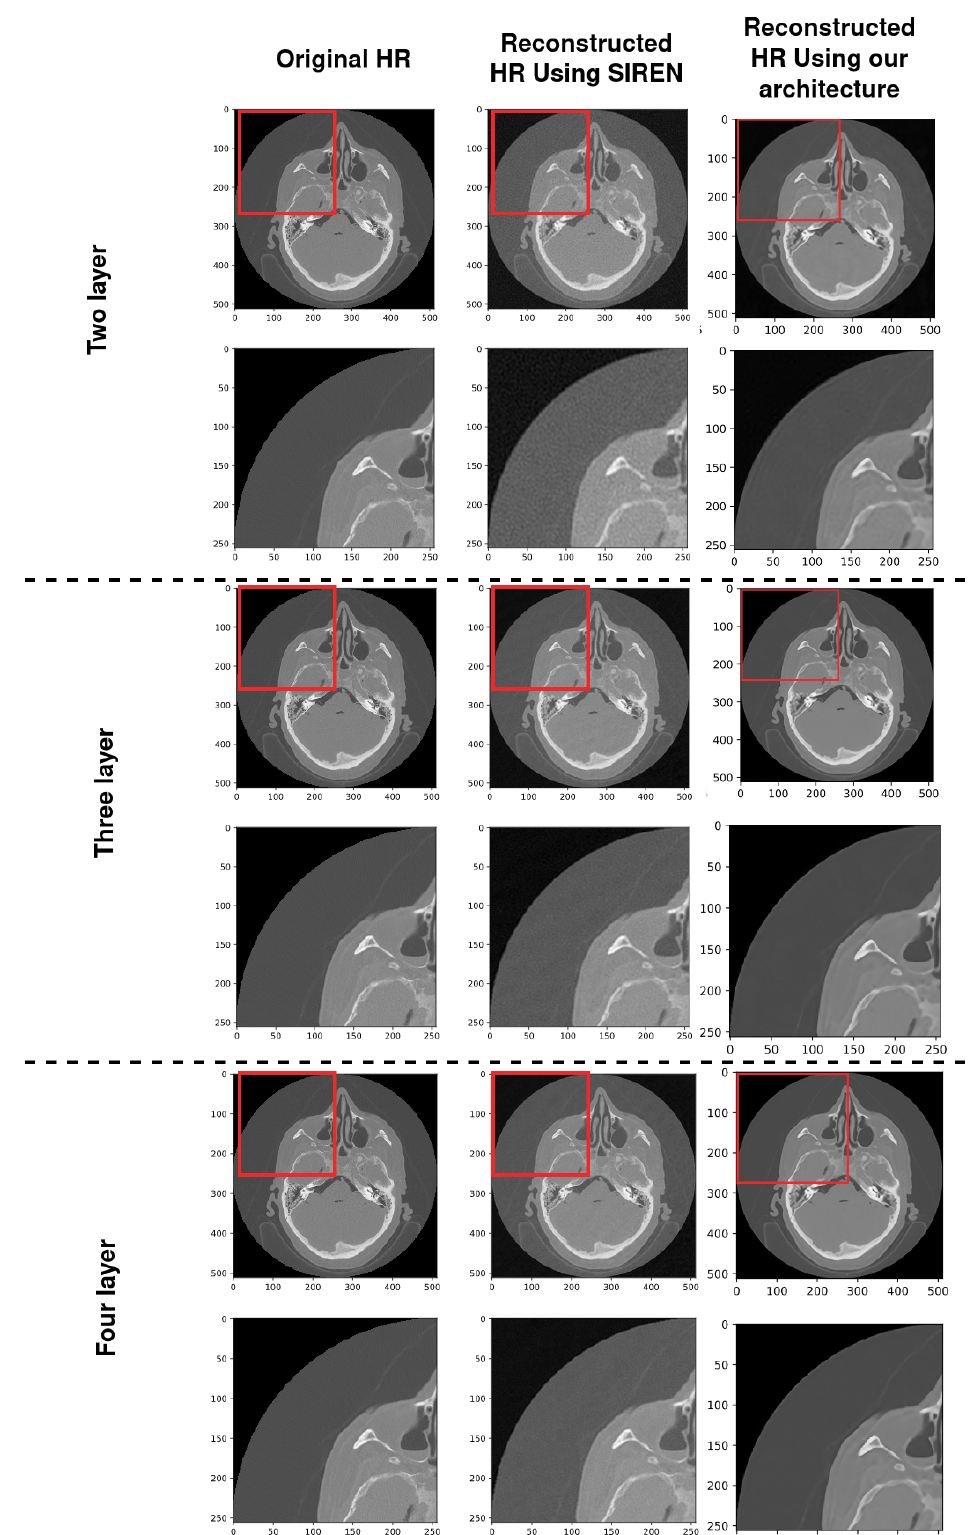
Figure 14. Comparison of the quality of reconstructed HR using SIREN in the Ref. [2] and using SIREN with our architecture with 2, 3 and 4 MLP